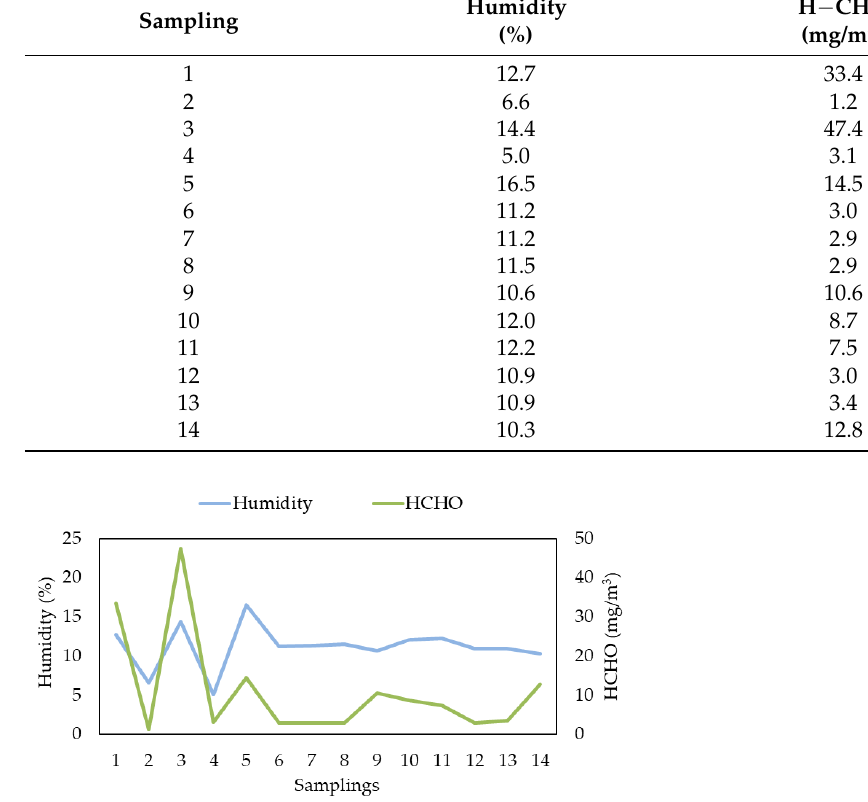
Figure 2. Relation between measured humidity and H − CHO concentrations obtained by Lab. RSE during First Campaign.